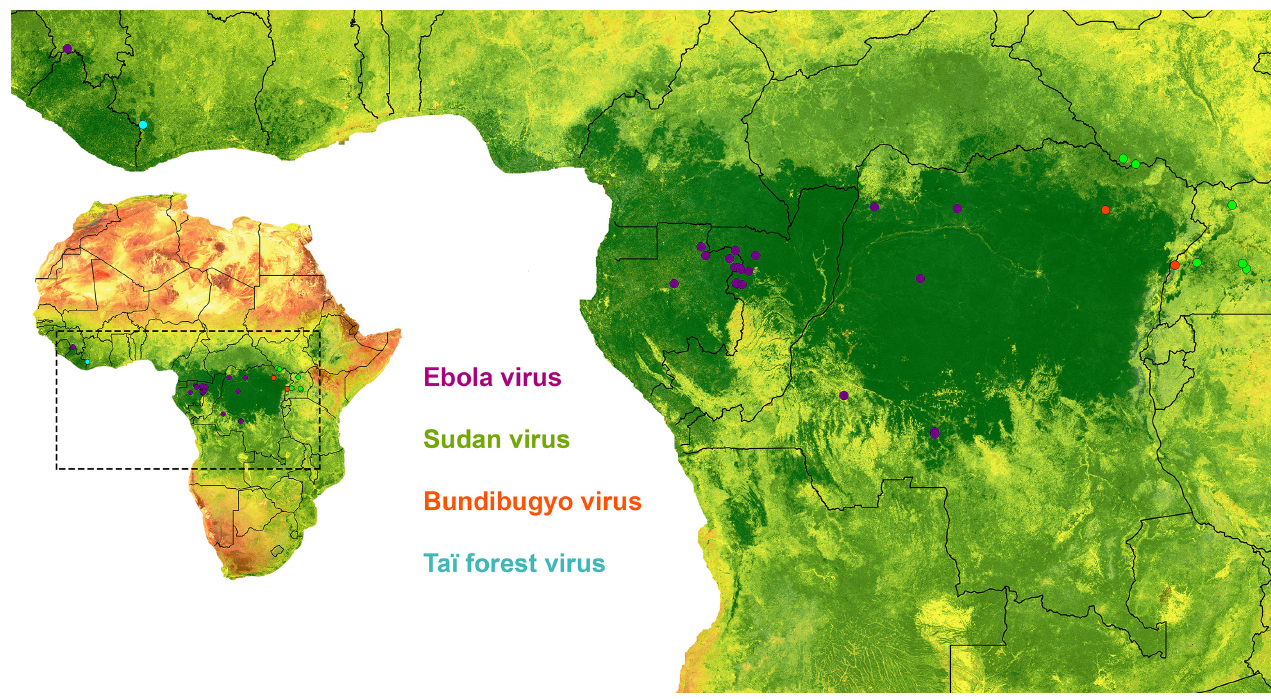
Fig 1. Locations of ebolavirus index cases 1976 – 2014.